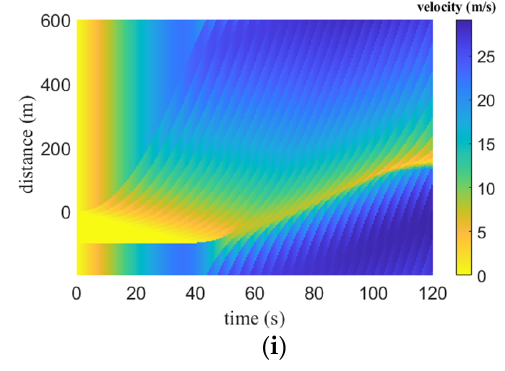
Figure 5. Velocity over time and space for the ID and proposed models over a circular road of length 800 m: ( a ) ID model, 𝛿 = 1 ; ( b ) ID model, 𝛿 = 4 ; ( c ) ID model, 𝛿 = 20 ; ( d ) proposed model, 𝑇 = 0.1 s; ( e ) proposed model, 𝑇 = 0.5 s; ( f ) proposed model, 𝑇 = 1 s. ( g ) proposed model, 𝑇 = 1.6 s; ( h ) proposed model, 𝑇 = 2.7 s; ( i ) proposed model, rearward velocity 33.3 m/s, forward velocity 24.5 m/s, rearward time headway 4 s, and forward time headway 5 s. Table 5. Velocity and time for the ID and proposed models during and after the queue.